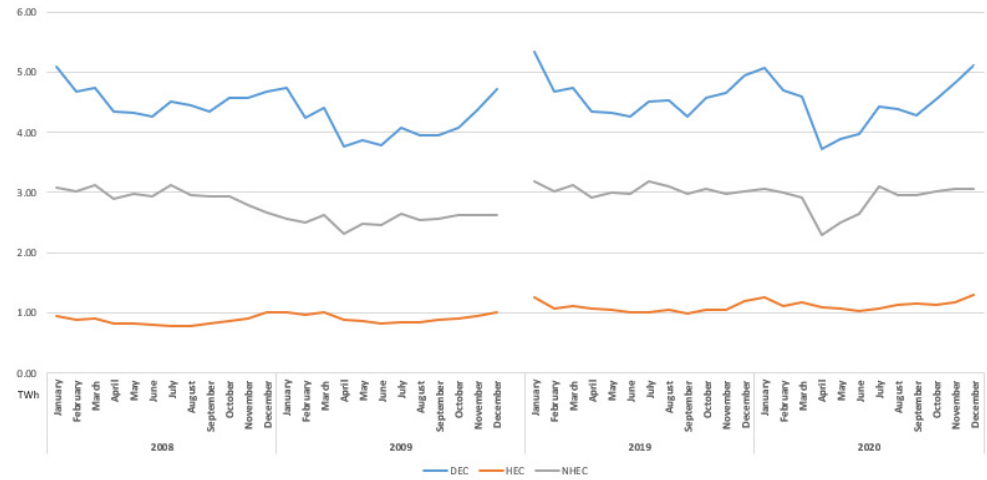
Figure 6. Comparative evolution of electricity consumption during the financial crisis vs. COVID-19 crisis.